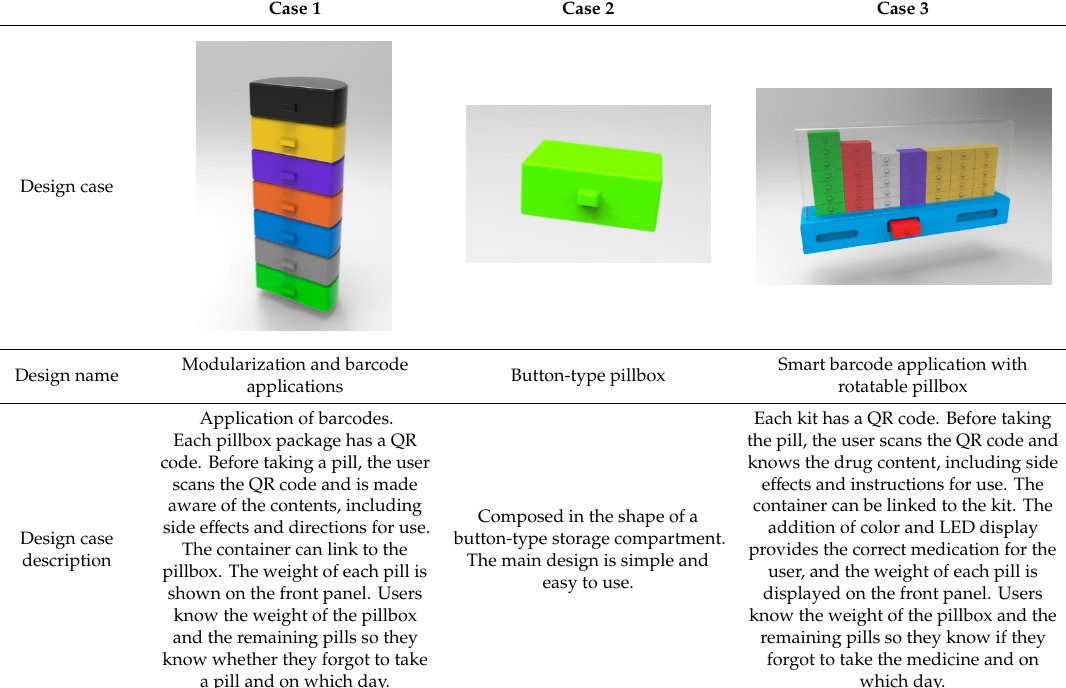
Table 7. Three types of new pillbox designs with di ff erent shapes for patients with chronic diseases. Table 6. Three types of new pillbox designs with different shapes for patients with chronic diseases. Table 6. Three types of new pillbox designs with different shapes for patients with chronic diseases. Table 6. Three types of new pillbox designs with different shapes for patients with chronic